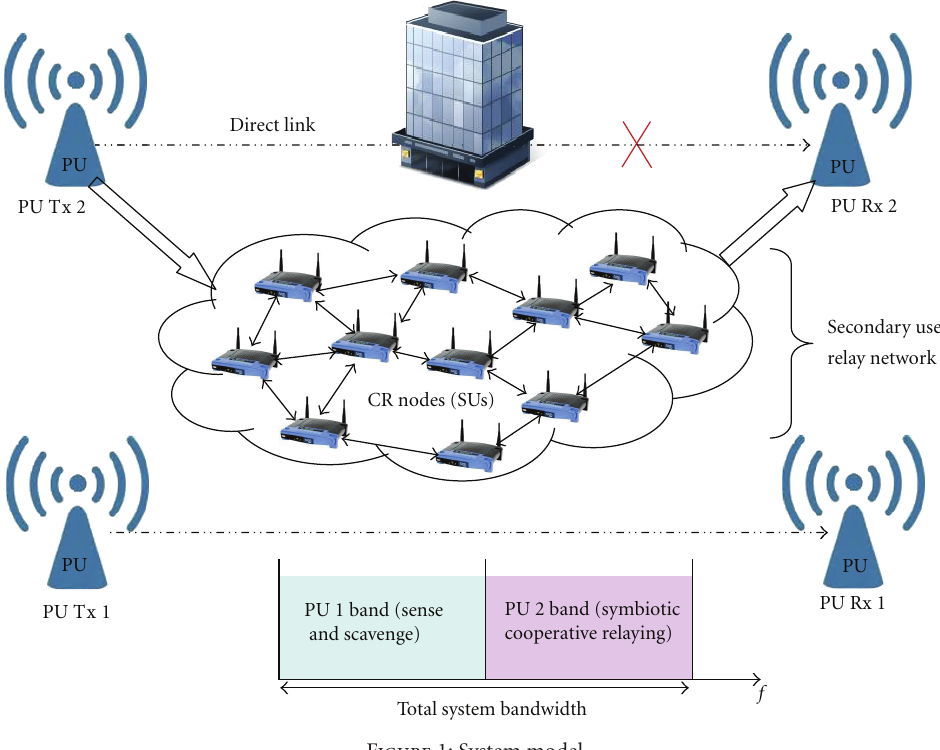
Figure 1: System